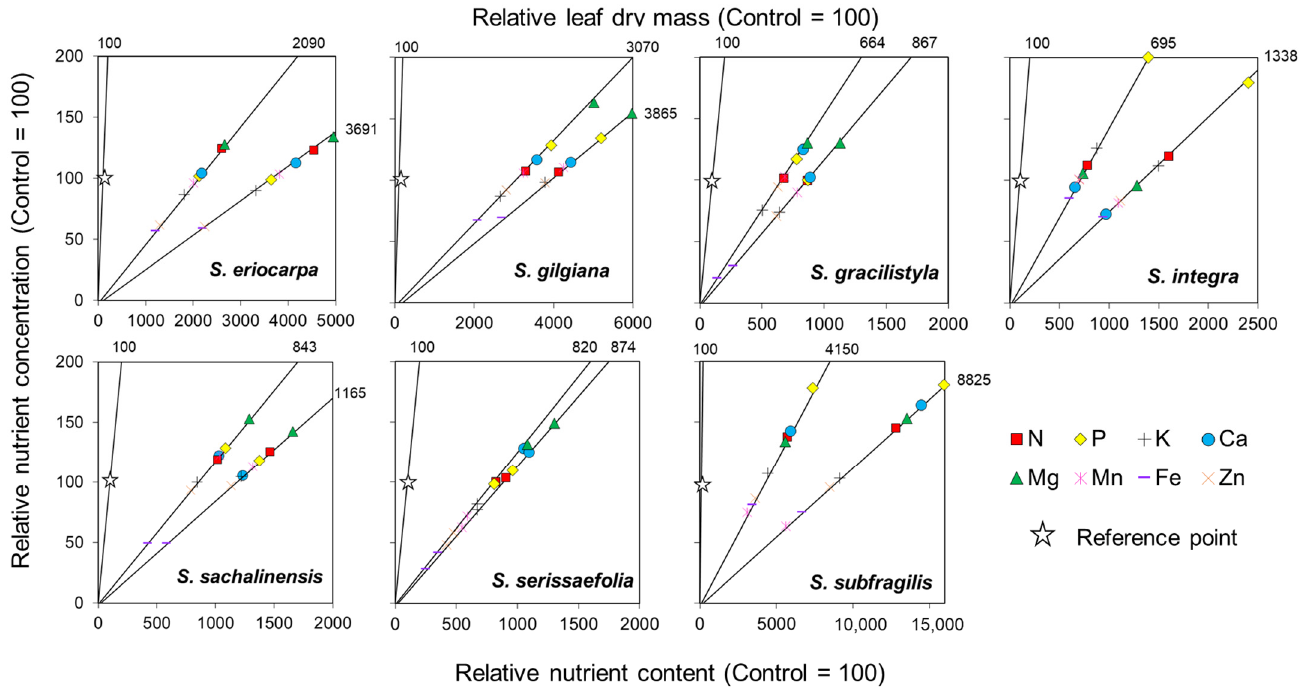
Figure 9. Comparison of relative nutrient concentrations in the leaves and leaf dry mass of seedlings of seven willows. The content isograms represent the combination of dry mass and concentrations required for the values in LM and HM treatments relative to those in the Con treatment. The value 100 represents the dry mass and concentration of nutrients in the Con treatment.